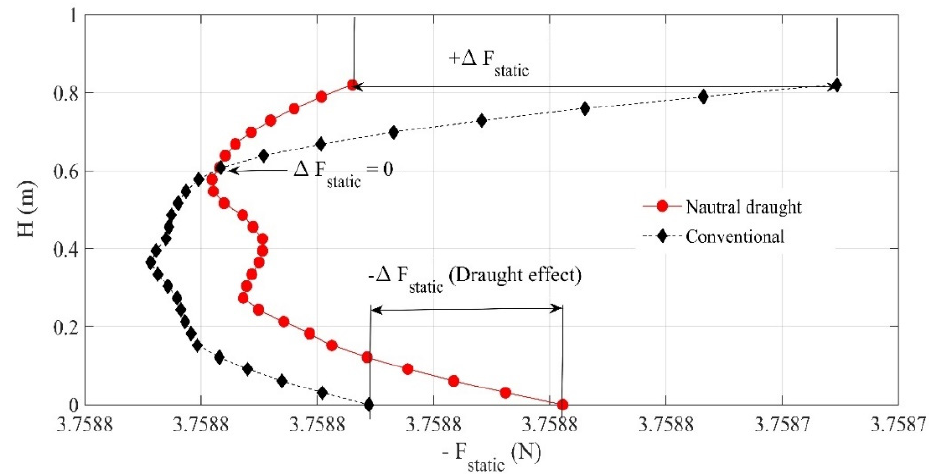
Figure 10. The variation of the static pressure force (F static ) (N) along the airstream passage. Table 3. Parametric information related to the performance of a solar collector, based on average